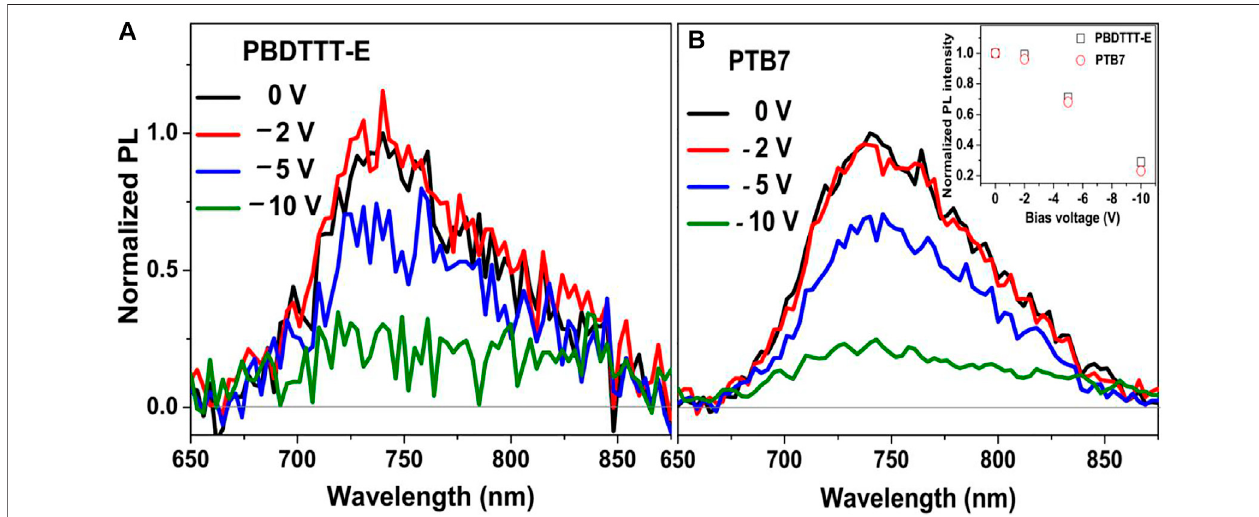
FIGURE 4 | Normalized PL spectra of (A) neat PBDTTT-E and (B) PTB7 devices after photoexcitation at 532 nm under the various bias electrical fi eld. The inset picture presents the normalized PL intensity of PBDTTT-E and PTB7 devices changed with the bias voltages.